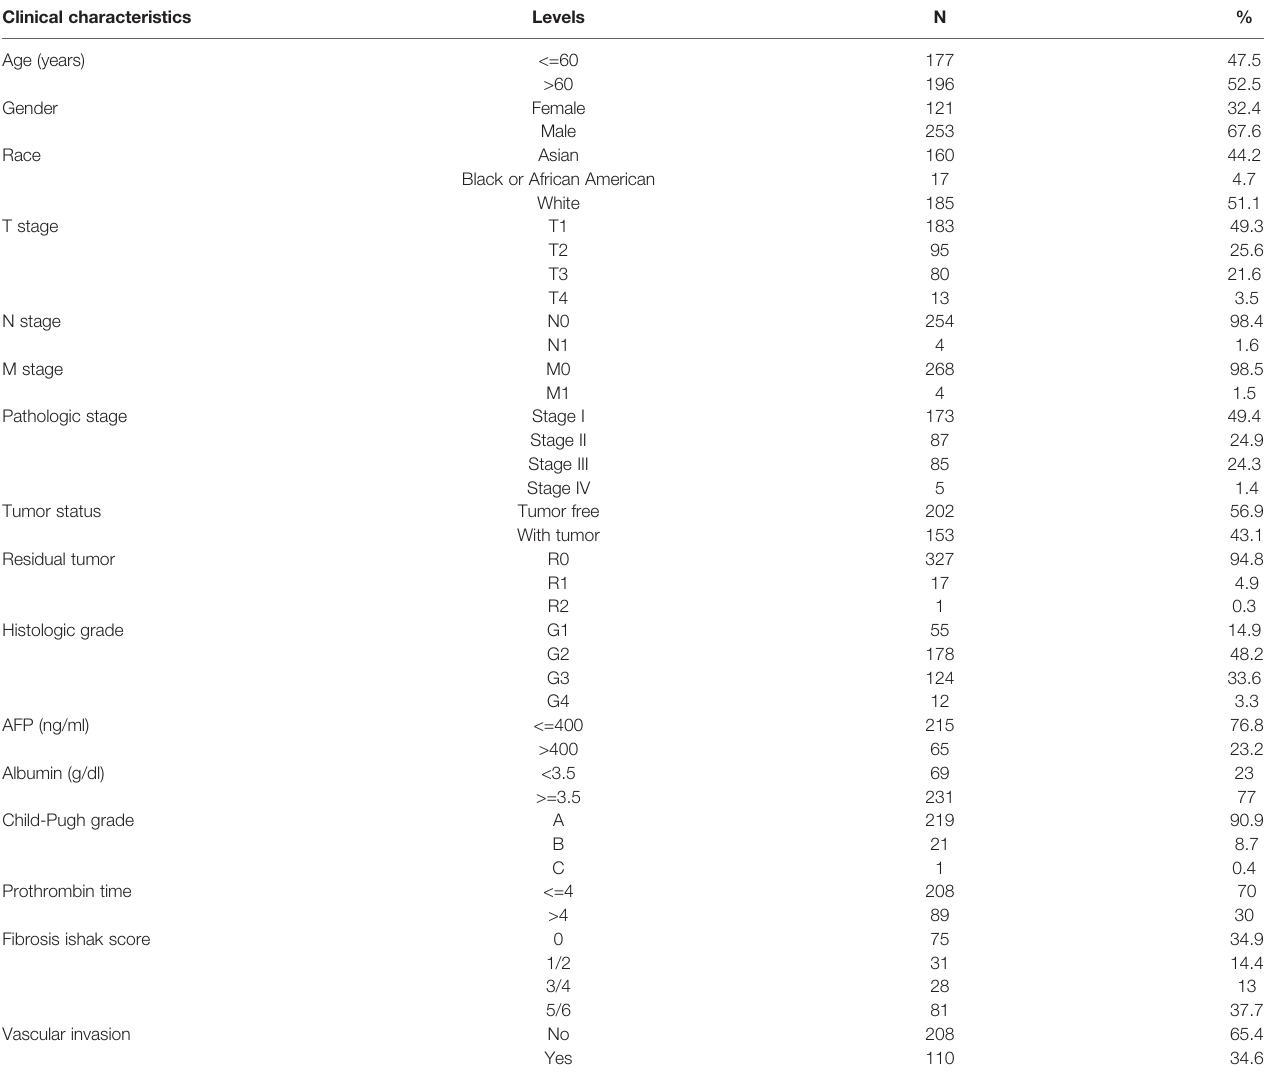
TABLE 1 | Clinical characteristics of the HCC patients. Clinical